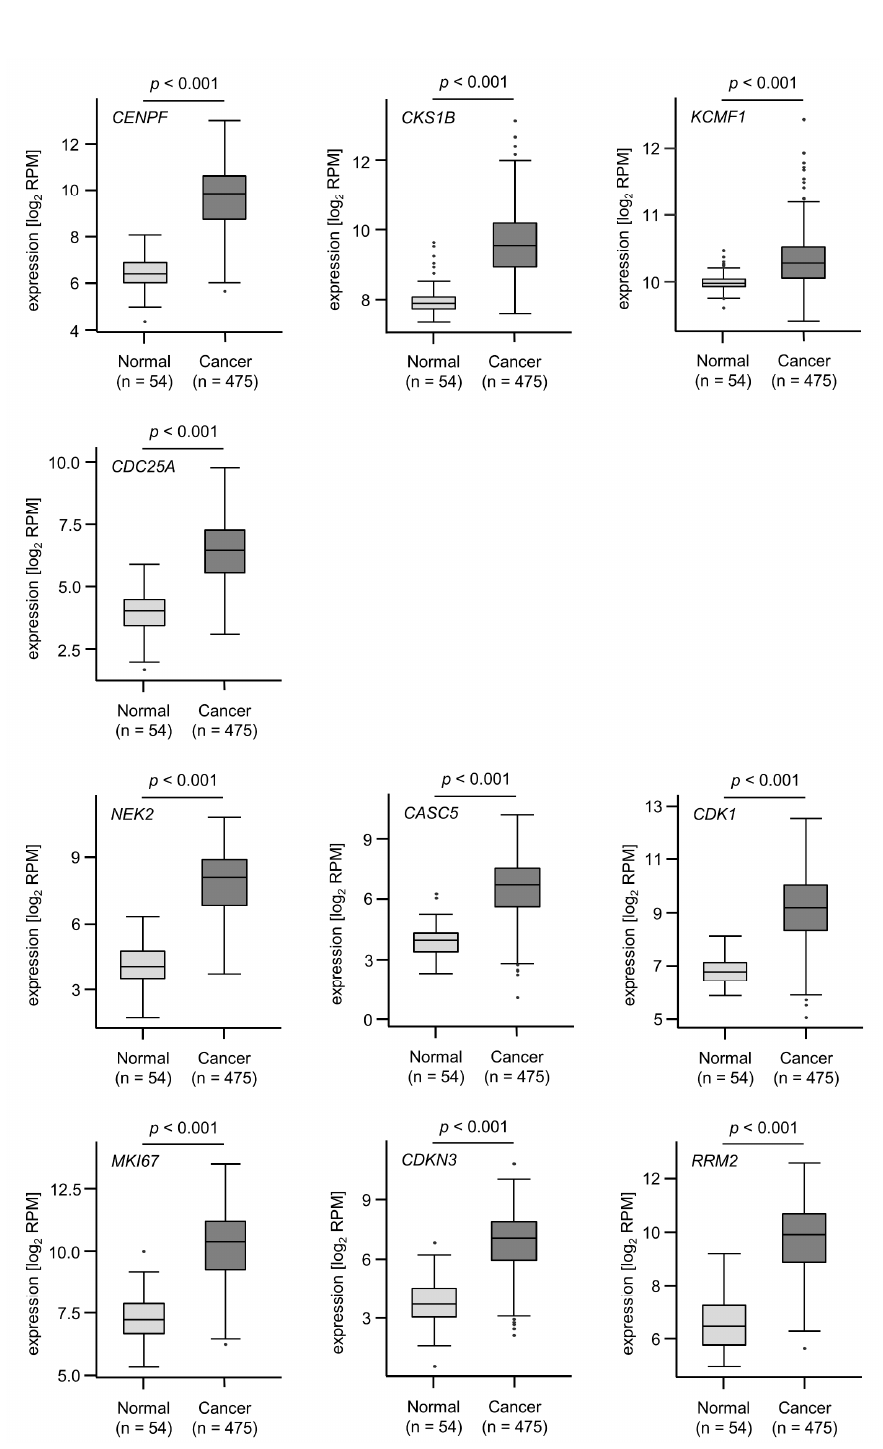
and low expression groups. The red and blue lines represent the high and low expression groups, respectively. High expression mRNA of 18 genes ( CKS1B , KCMF1 , CENPF , CASC5 , MKI67 , ESCO2 , FANCI , SGOL1 , MCM4 , KIF11 , NEK2 , MTHFD2 , NCAPG , RRM2 , FAM136A , ZWINT , CDK1 and CDKN3 ) significantly predicted worse survival (5-year overall survival rate) in patients with LUAD. The expression data were downloaded from http://www.oncolnc.org.